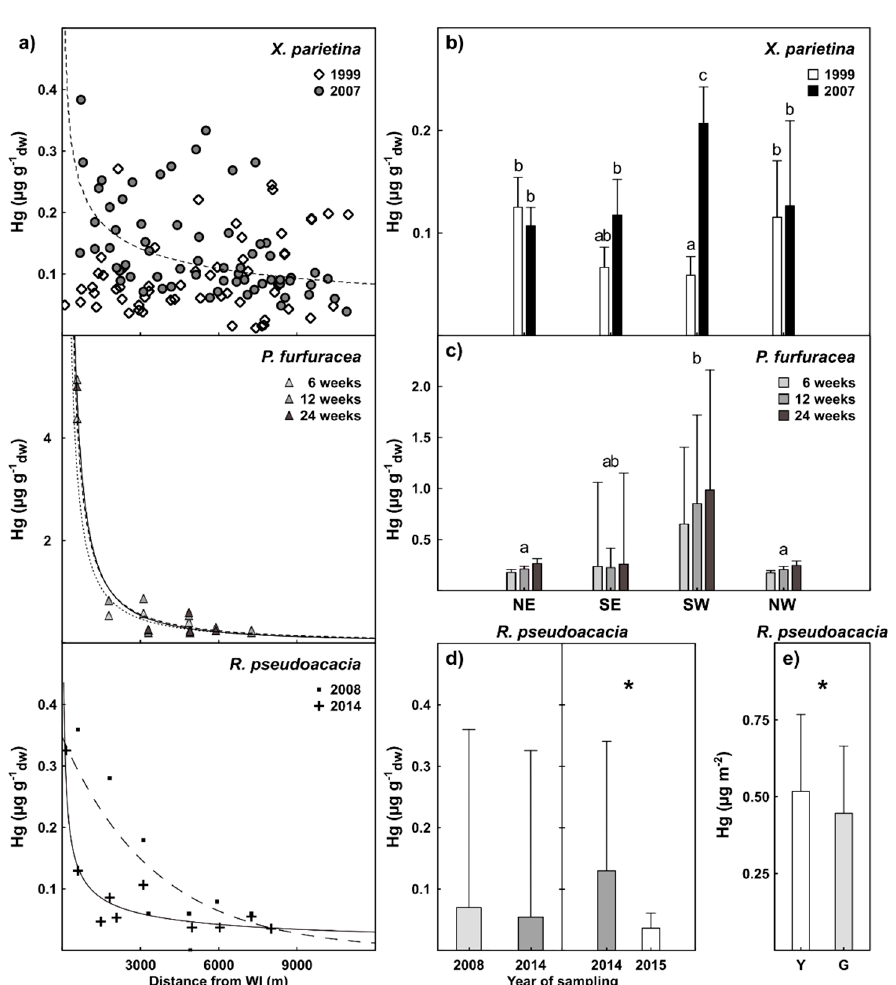
Figure 2. ( a ) Trends of Hg concentration vs. distance of exposure or sampling sites from the WI; ( b , c ) results of generalized linear model (GLM)-based comparison performed on samples of the lichens Xanthoria parietina and Pseudevernia furfuracea (see Section 2.5; data elaborated from the work of [18]); ( d ) median comparison between leaves of Robinia pseudoacacia sampled in 2008 and 2014 in the whole study area and in 2014 and 2015 in three sites close to the WI (see text for explanation); ( e ) comparison of Hg content in yellow (Y) and green (G) R. pseudoacacia leaves collected in the same ten sites in 2014. Different letters in ( b , c ), as well as asterisks in ( d , e ), indicate significant difference for p < 0.05.